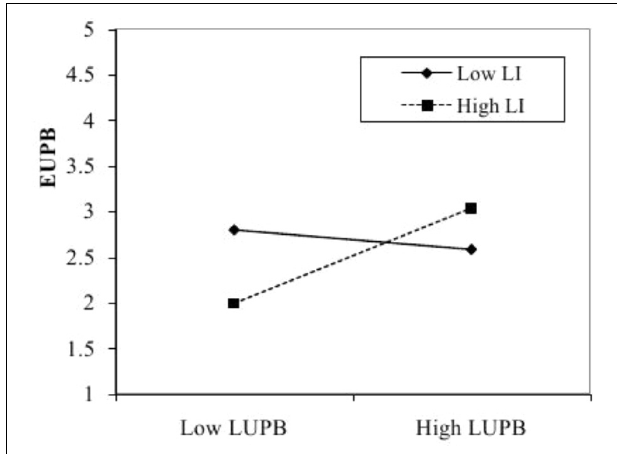
FIGURE 1 | Interaction between LUPB and leader identification on EUPB. LUPB, leaders’ unethical pro-organizational behavior. EUPB, employees’ unethical pro-organizational behavior. LI, leader identification.